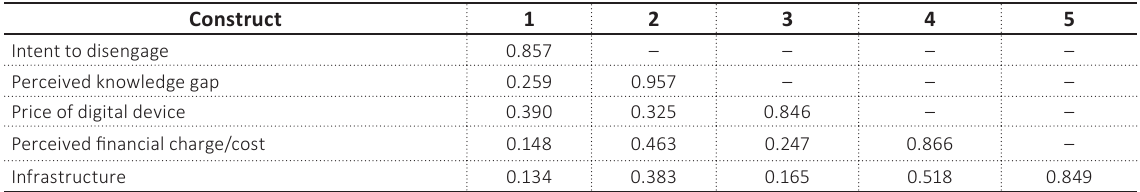
Table 3. Discriminant validity test – Fornell-Larcker